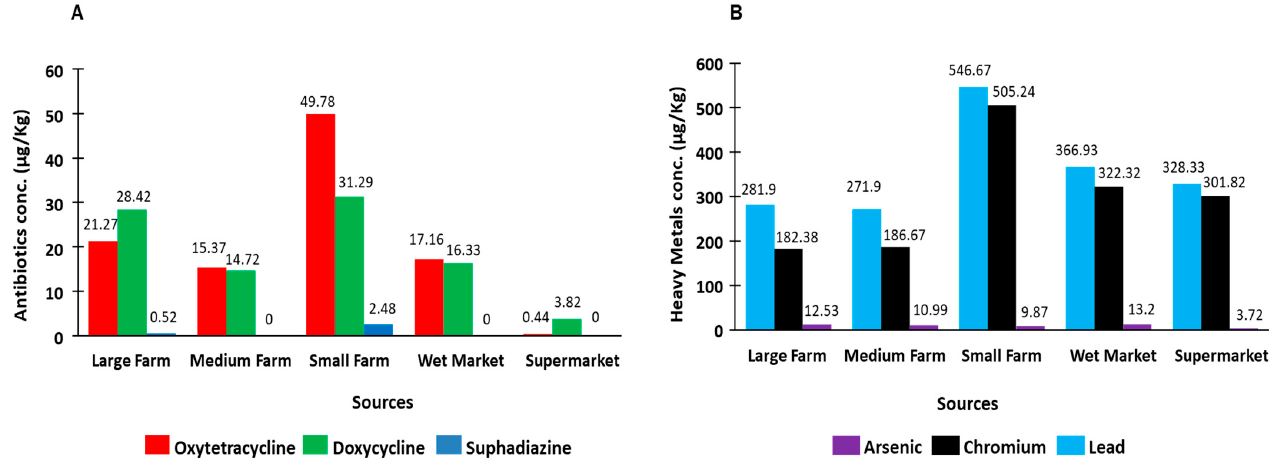
Figure 4. Concentration of antibiotic residues ( A ) and heavy metals (B) in edible broiler composites collected from various large farms, medium farms, small farms, broiler wet meat markets and su- permarkets in Bangladesh.